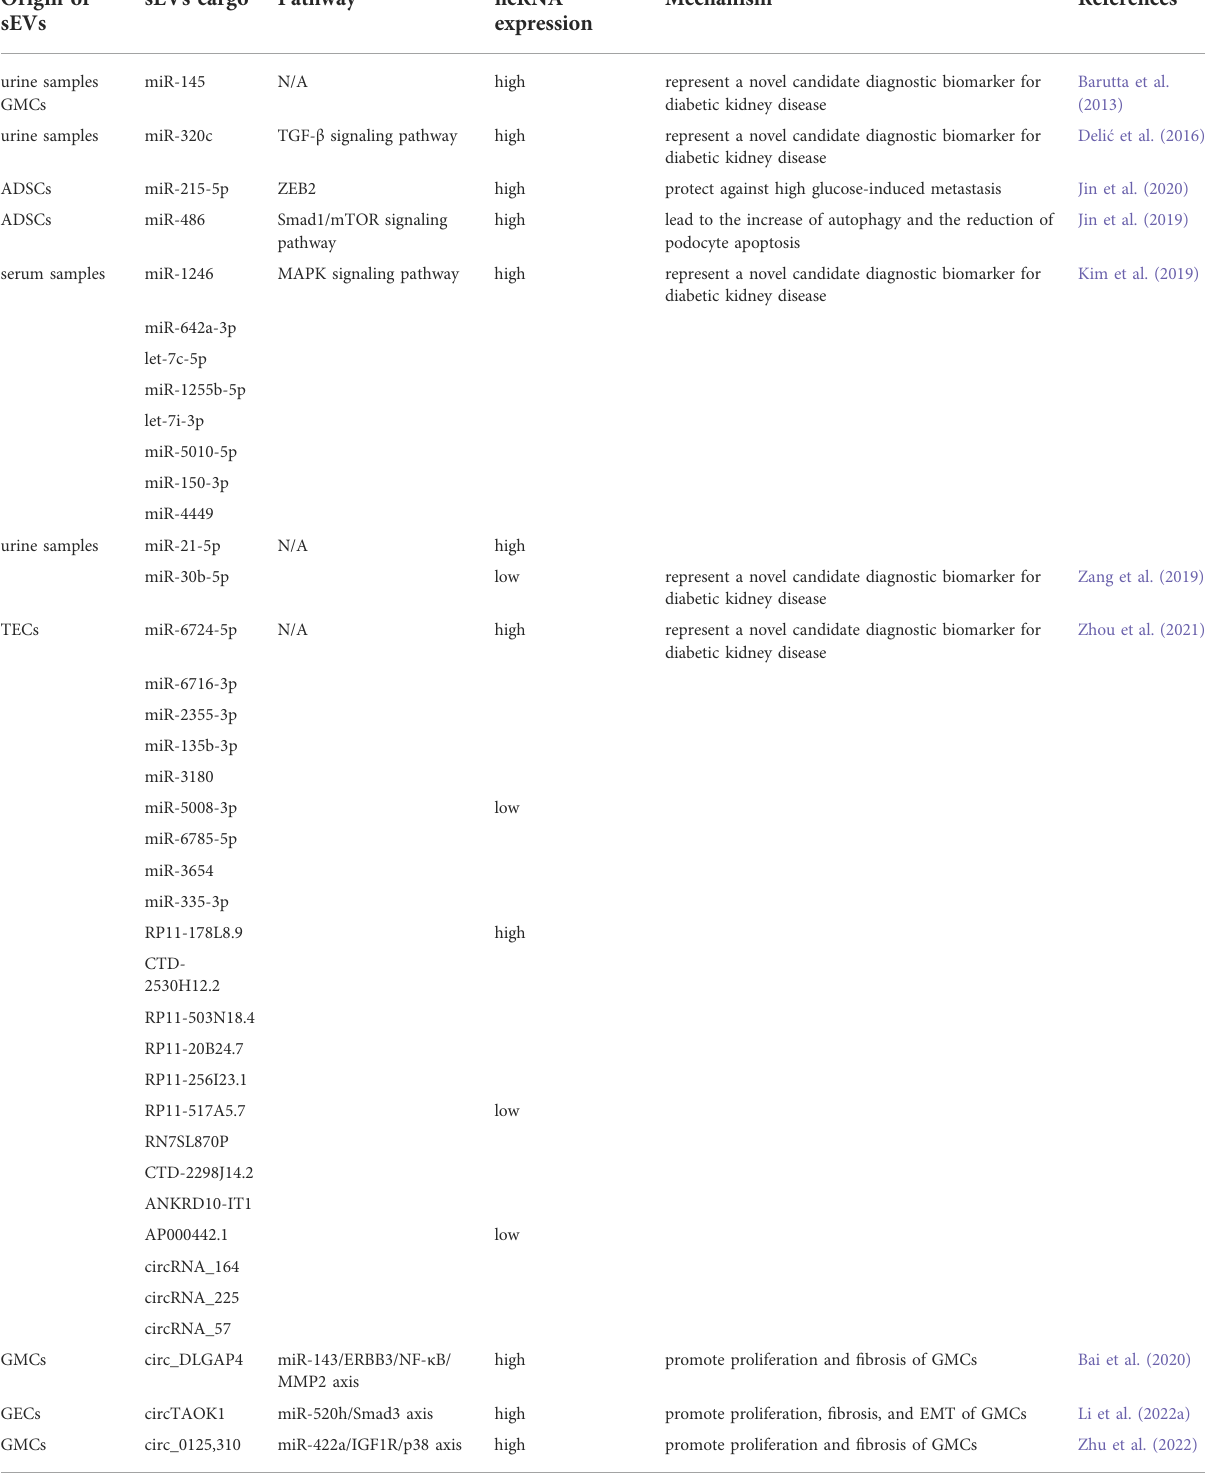
TABLE 1 The role of small extracellular vesicle non-coding RNAs in diabetic kidney